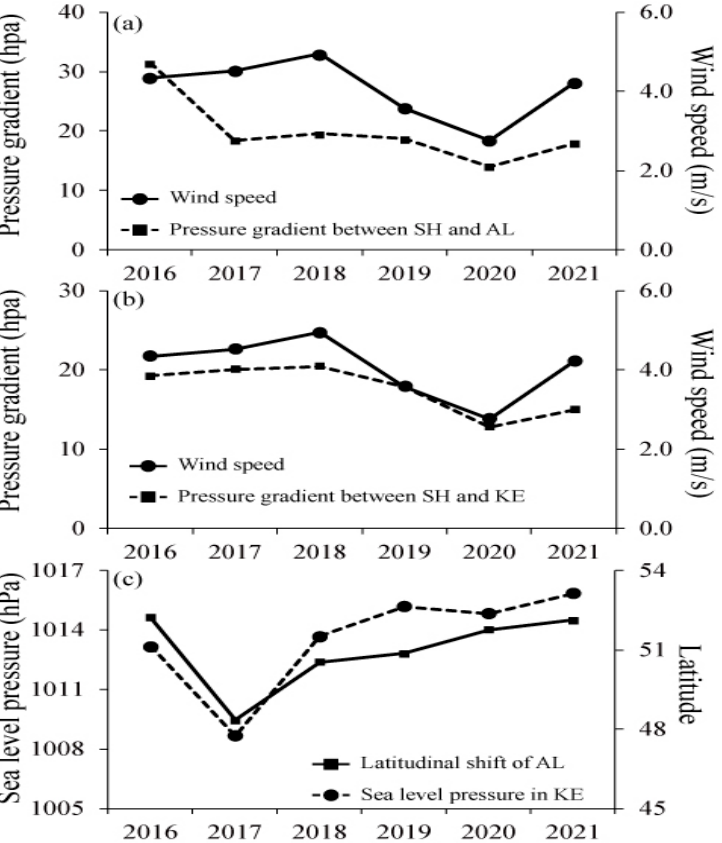
Figure 11. Inter-annual changes in wind speed in the western part of East/Japan Sea and pressure gradient between ( a ) Siberian high (SH) and Aleutian low (AL), ( b ) SH and Kuroshio Extension (KE) and ( c ) latitudinal shift of Aleutian low with sea level pressure in the KE region.